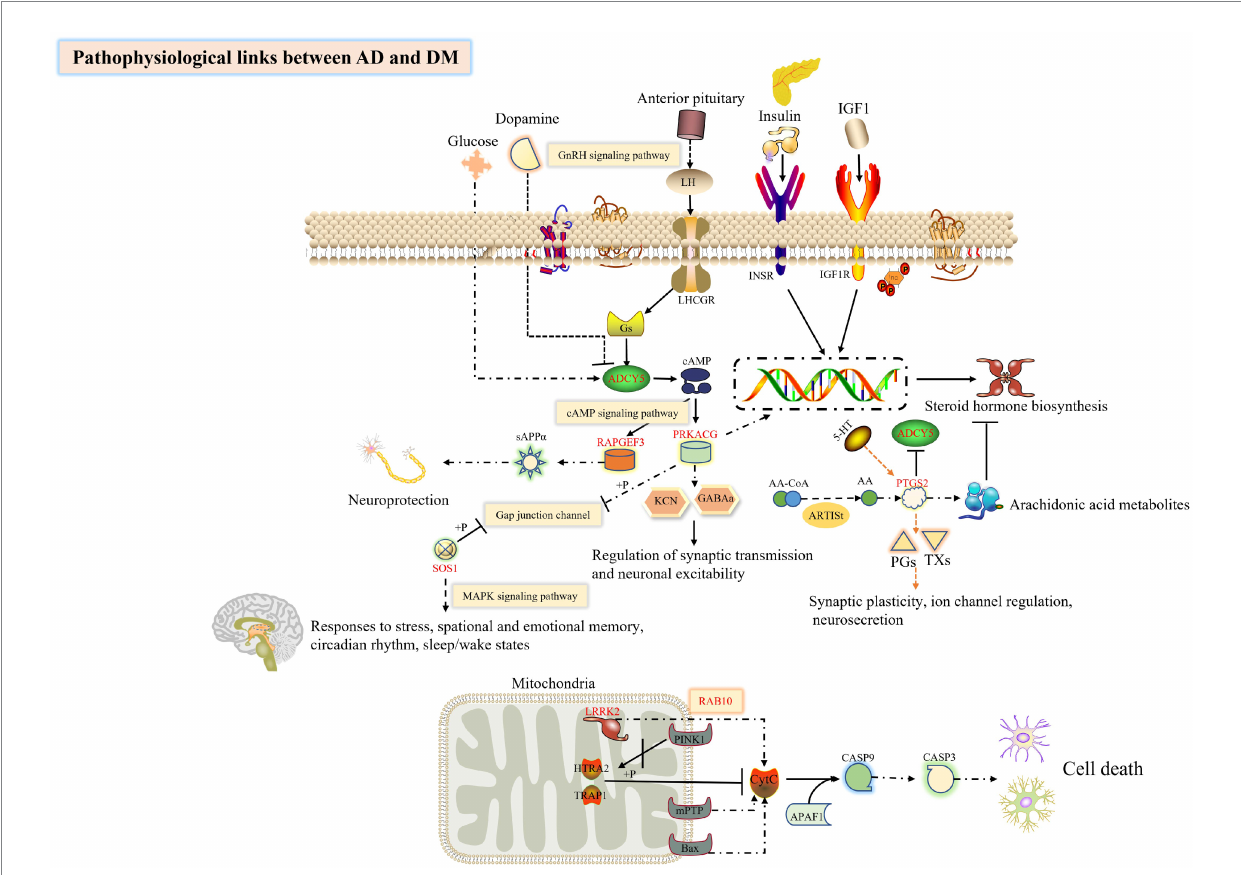
FIGURE 10 Exploring the hub genes related to the pathogenesis of DM complicated with AD by bioinformatics analysis. This figure was drawn by the ScineceSlides